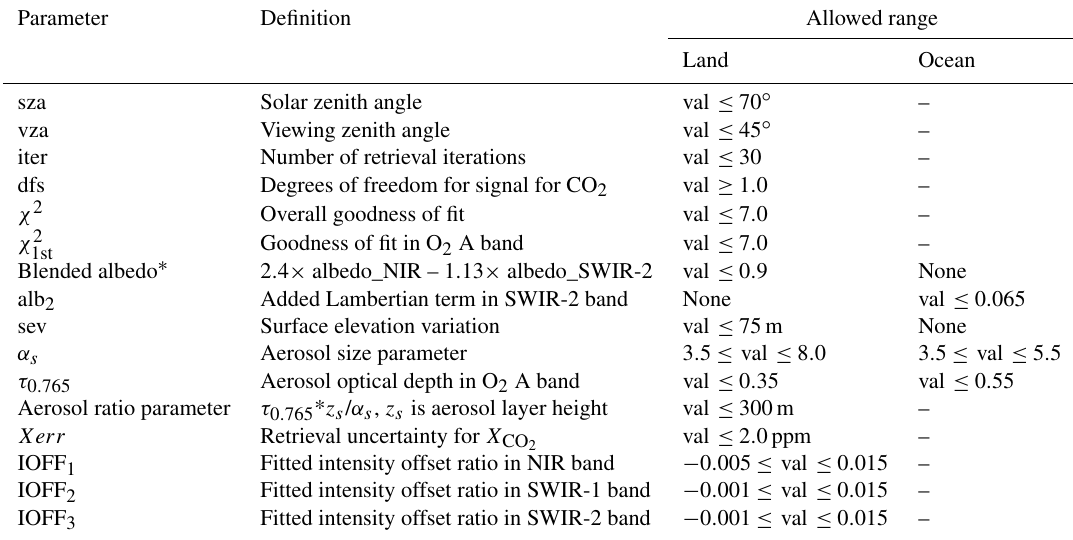
Table 2. Settings of the filters used for excluding RemoTeC/OCO-2 X CO retrievals.